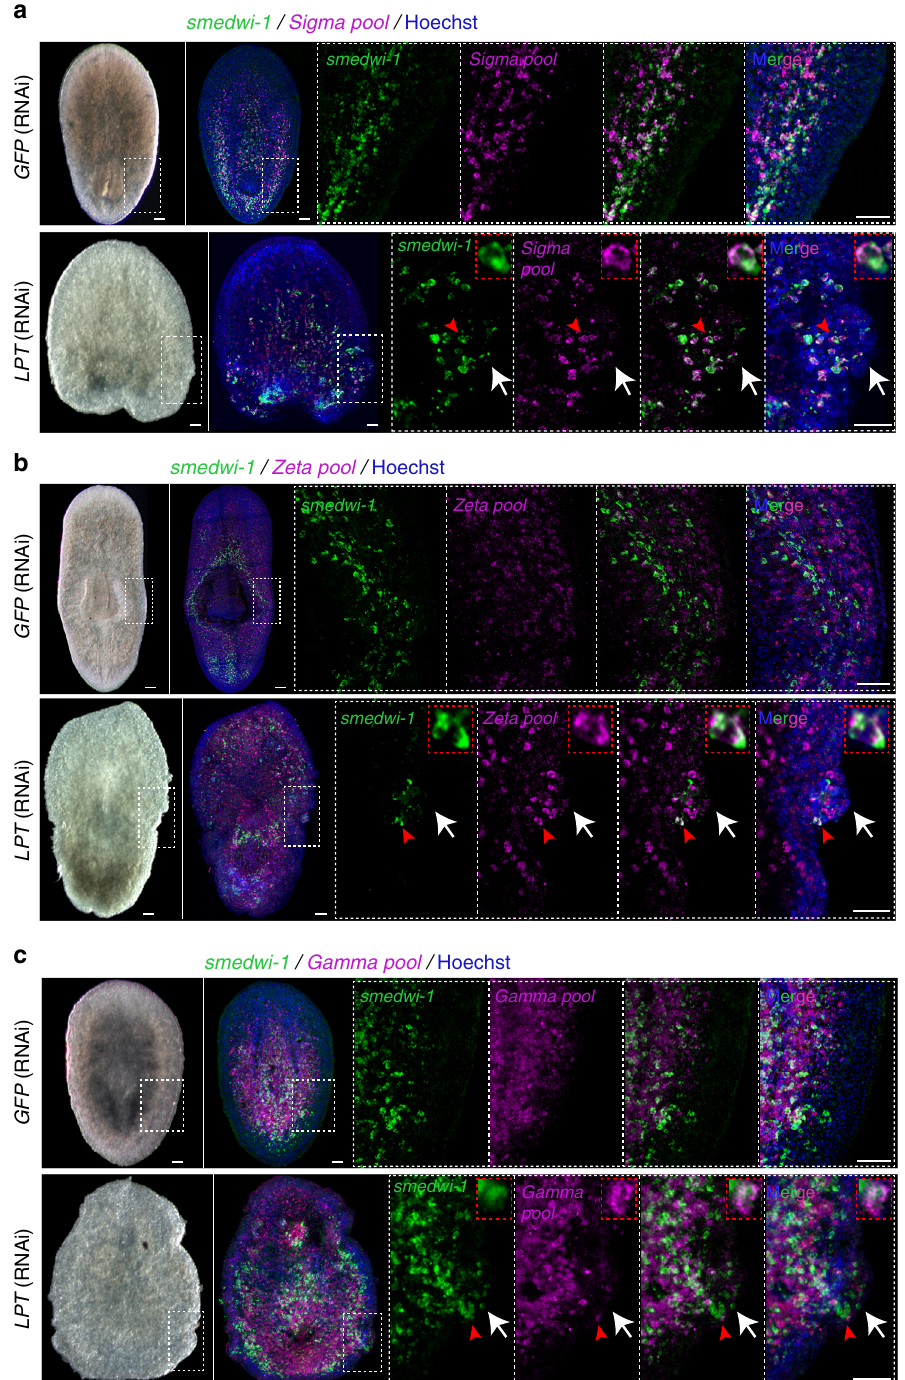
Fig. 5 Pluripotent as well as lineage restricted stem cells are present in outgrowths of LPT (RNAi) animals. a Head piece showing distribution of Sigma stem cells in GFP (RNAi) and LPT (RNAi) animals. Sigma stem cells are double positive for smedwi-1 and the ‘ Sigma pool ’ of RNA probes ( Soxp1 , Soxp2 ). White arrows in LPT (RNAi) animals point towards the outgrowth. Red arrows indicate a double-positive cell magni fi ed in red inset box. b Images showing distribution of Zeta stem cells in GFP (RNAi) and LPT (RNAi) animals. Zeta stem cells are double positive for smedwi-1 and the ‘ Zeta pool ’ of RNA probes ( zfp-1 , Soxp3, egr-1 ). White arrows in LPT (RNAi) animals point towards the outgrowth. Red arrows indicate a double-positive cell magni fi ed in red inset box. c Images showing distribution of Gamma stem cells in GFP (RNAi) and LPT (RNAi) animals. Gamma stem cells are double positive for smedwi-1 and the ‘ Gamma pool ’ of RNA probes ( gata4/5/6 , hnf4 ). White arrows in LPT (RNAi) animals point towards the outgrowth. Red arrows indicate a double-positive cell magni fi ed in red inset box. Scale bars: 50 μ